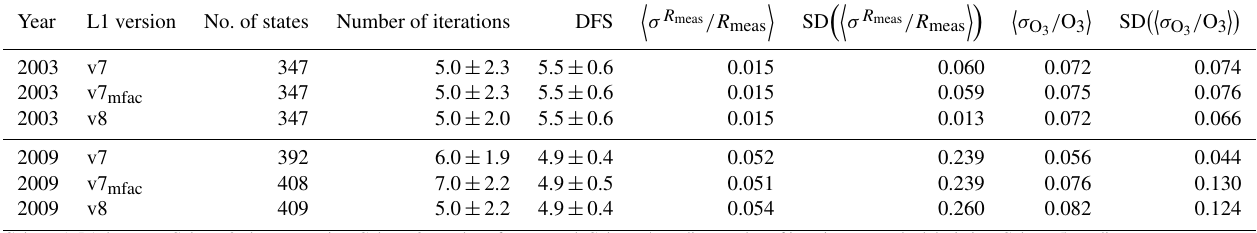
Table 3. Statistics of the uncertainties of the L2 ozone profile products that are retrieved using three different versions of L1 data sets (described in Sect. 2.1). This table contains the statistics of the curves shown in Fig. 3.